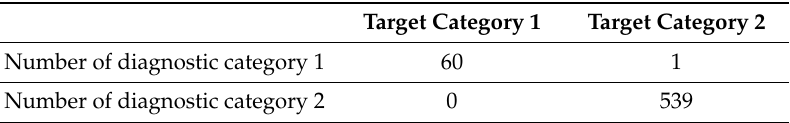
Table 8. The test results of random forest model.